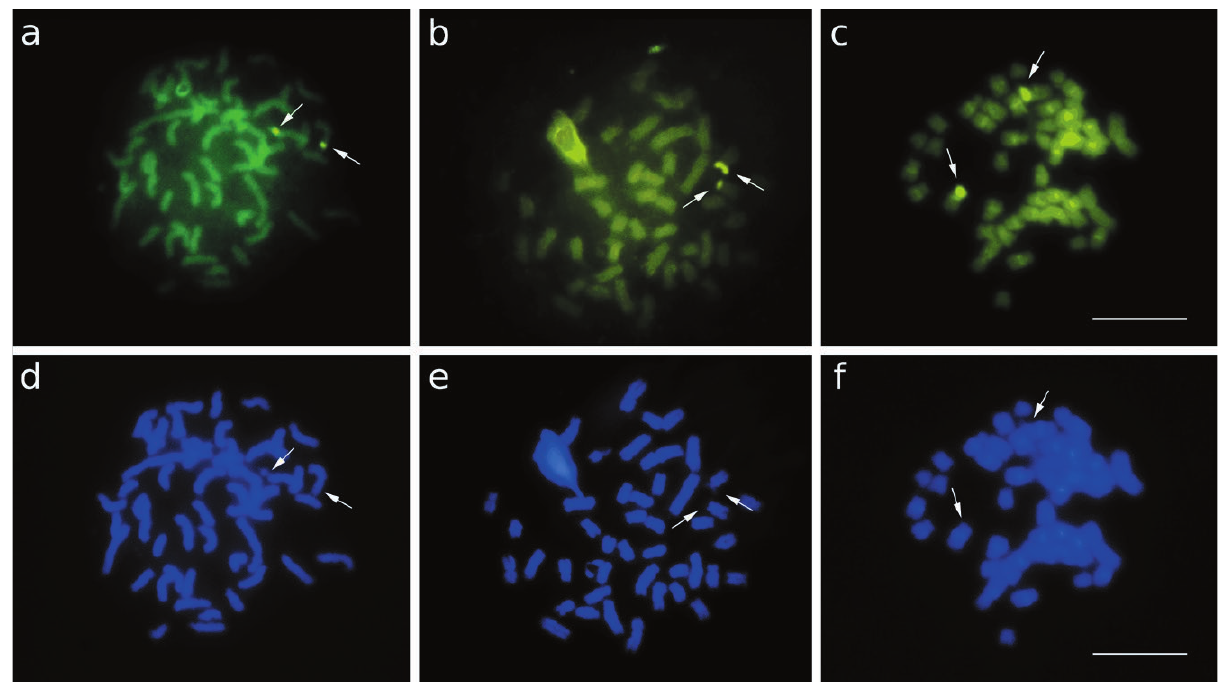
Figure 3. Metaphasis after sequential fluorescent staining with CMA 3 (a) and DAPI (b) of Moenkhausia dichroura , M. intermedia and M. sanctaefilomenae . Arrows indicate the NOR-bearing